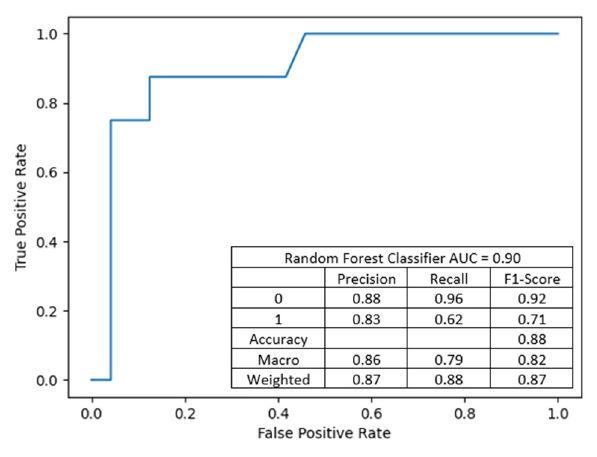
Figure 8. The model classifies patients slightly worse in terms of prediction of DGF occurrence.